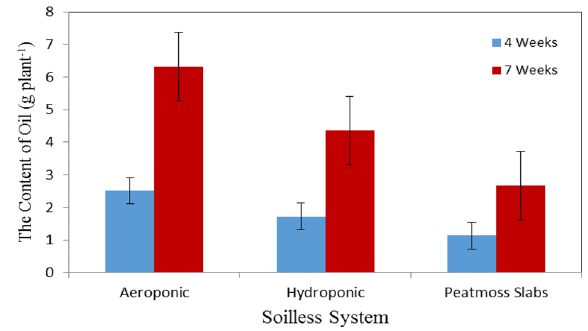
Figure 7. The basil oil content grown in different soilless systems.